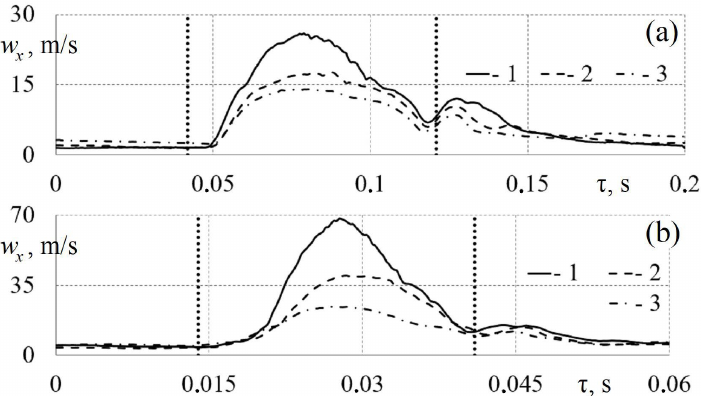
Figure 6. Dependences of the local ( l x = 100 mm) air flow velocity w x in the intake system of a piston engine on time τ for crankshaft speeds of 600 rpm ( a ) and 1800 rpm ( b ) for different intake channel diameters: 1— d = 26 mm; 2— d = 32 mm; 3— d = 40 mm. The vertical lines indicate the opening and closing times of the intake valve.